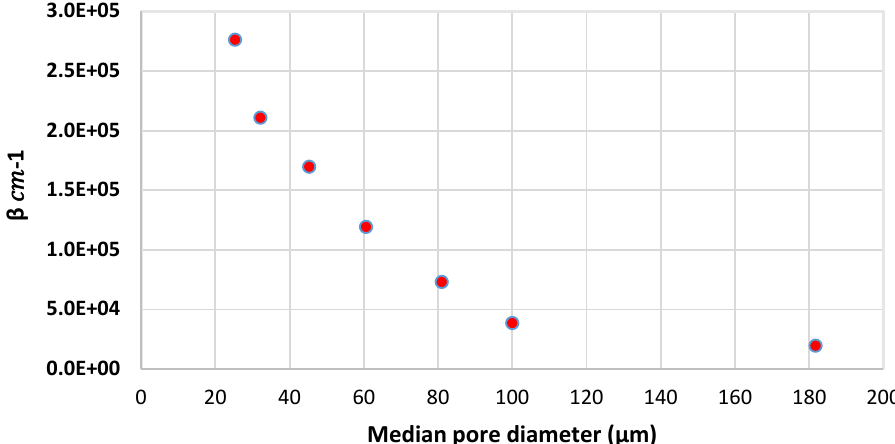
Figure 10. The effect of tortuosity on inertia coefficient β .